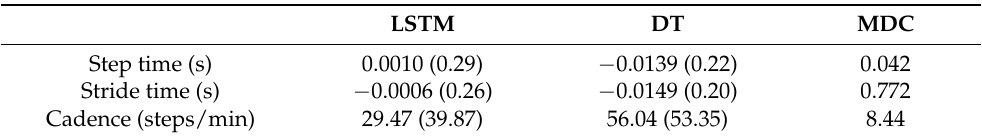
Table 2. Average and standard deviation (in brackets) difference between manual and auto- mated foot strike stride parameter outcome measures for LSTM and decision tree (DT) models. MDC = minimum detectable change.